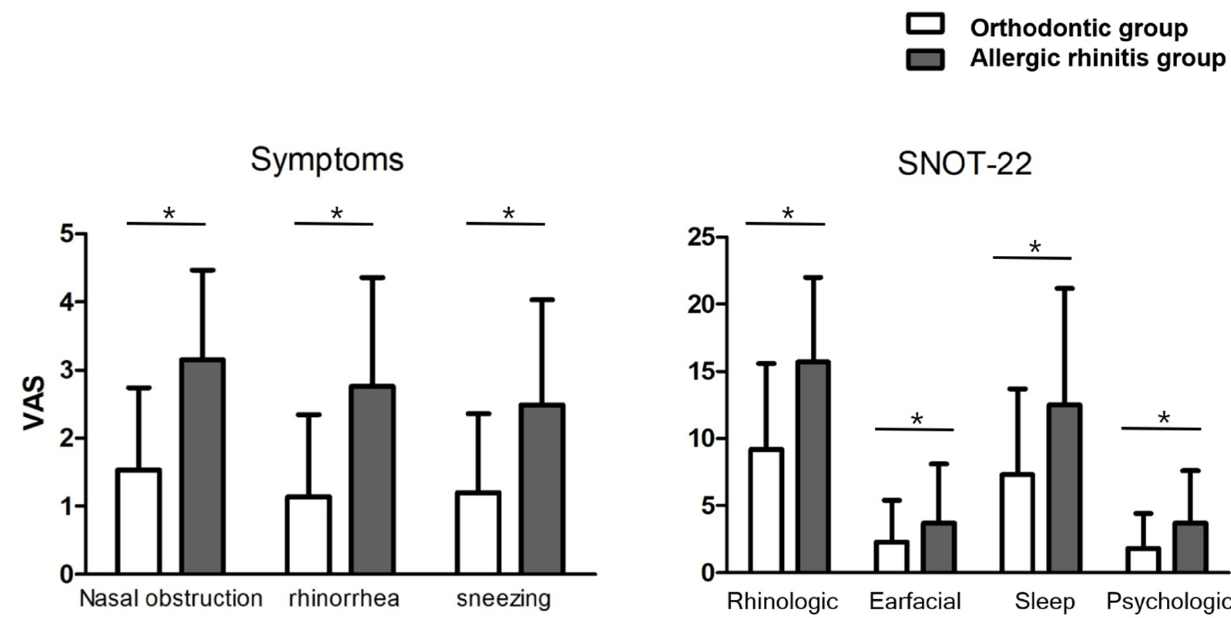
Figure 2. Comparison of visual analogue score (VAS) for symptoms of allergic rhinitis and sino-nasal outcome test score (SNOT-22) between the orthodontic group and the allergic rhinitis group. A paired t -test was used to compare the two groups. (* p < 0.001). Table 4. Comparison of subjective/objective findings between the skin prick test (+) orthodontic group and the allergic rhinitis (control) group.